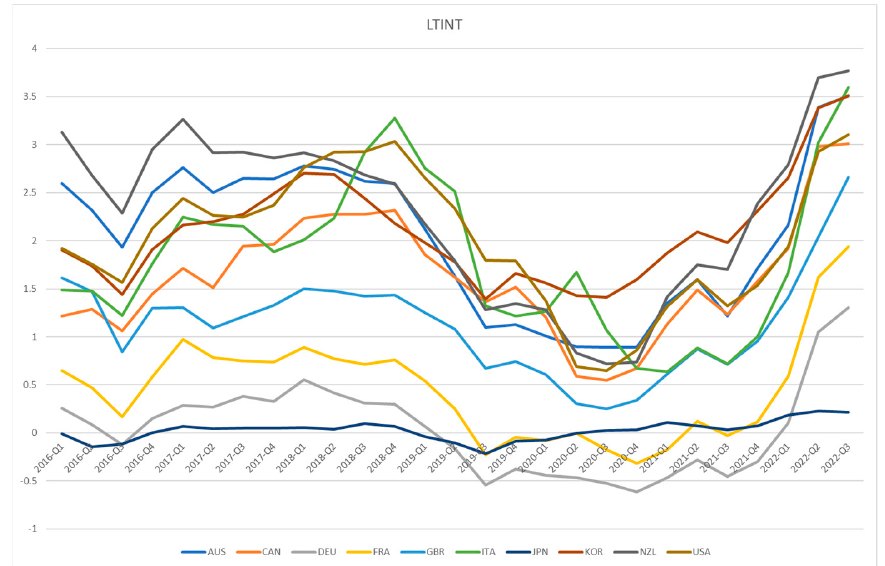
Figure 6. Long term interest rates before and after the outbreak of COVID-19. Source: data from OECD (2022a) [36]. Legend: Australia (AUS), Canada (CAN), Germany (DEU), France (FRA), Great Britain (GBR), Italy (ITA), Japan (JAP), South Korea (KOR), New Zealand (NZL), and the United States of America